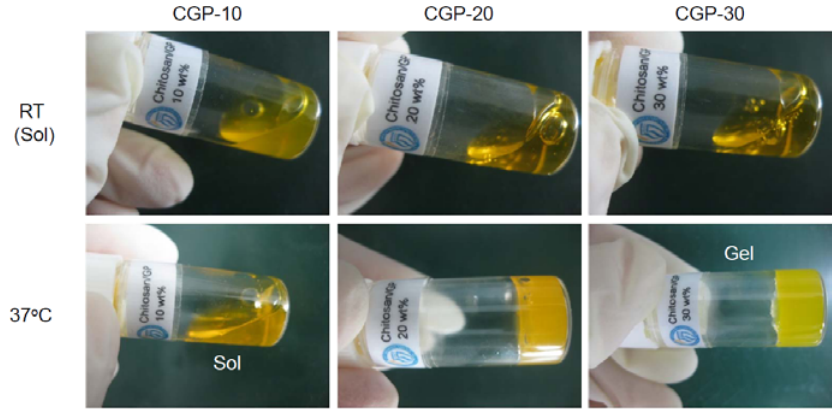
Figure 3. Images of BSA-FITC-loaded CGP-10, CGP-20 and CGP-30 at room temperature and 37 °C after 4 h.